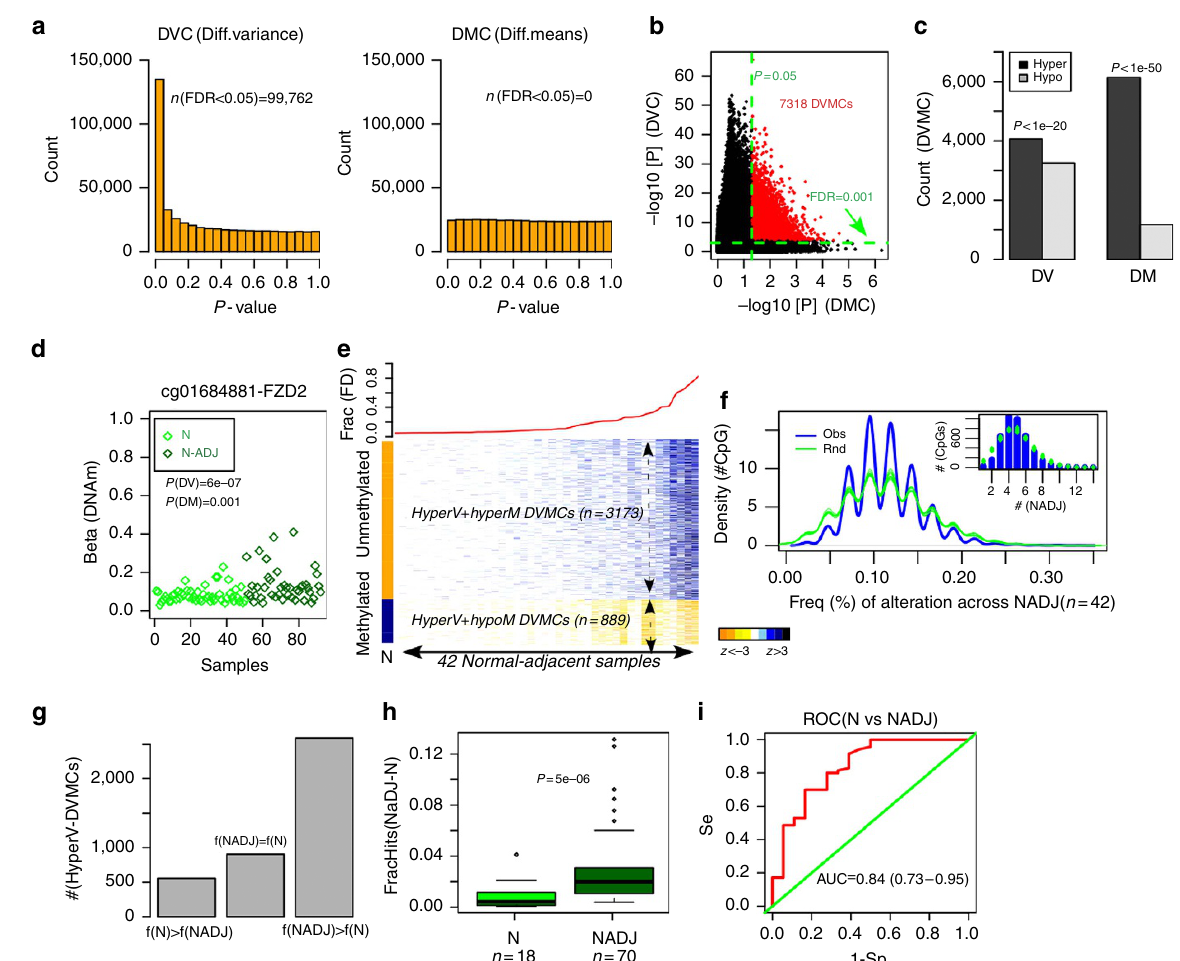
Figure 2 | Identification of stochastic DNA methylation field defects in breast cancer and validation. ( a ) Histograms of P -values from Bartlett’s test (DVC-differentially variable CpGs) and t -tests (DMC-differentially methylated CpGs) comparing 50 normal breast tissue samples from healthy women to 42 normal-adjacent samples from breast cancer patients. The number of probes passing an FDR-corrected threshold of 0.05 are shown. ( b ) Definition of the 7,318 differentially variable and differentially methylated CpGs (DVMCs), as those probes passing an FDR threshold for DVof 0.001 and an uncorrected P -value threshold for DM of 0.05. ( c ) Relative numbers of DVMCs that are hyper-or-hypovariable (DV), and hyper-or-hypomethyled (DM). Binomial P -values are given. ( d ) The DNAm profile of a hypervariable þ hypermethylated DVMC. Y axis labels the DNA methylation beta-value, x -axis labels the samples. P -values shown are for a Bartlett’s test, which tests for DV, and for a t -test, which tests for differential average methylation (DM). ( e ) Upper panel: fraction of hypervariable DVMCs significantly altered in each normal-adjacent sample, with samples ordered in increasing order. Left colour bar depicts the average DNAm beta-value of the hypervariable DVMCs across the 50 normal samples from cancer-free women. Orange: beta-value o 0.2, blue: beta- value 4 0.6. Heat map depicts the z -scores of differential DNAm change for each DVMC and normal-adjacent sample relative to the normal state, with samples ordered according to the overall fraction of alteration. ( f ) Density-histogram plot of the number of hypervariable DVMCs exhibiting a given fraction of DNAm alterations across the 42 normal-adjacent samples (blue curve). In green, we show the density obtained from Monte-Carlo randomization. Inlet figure depicts the same data, but using absolute numbers of CpGs ( y axis) and actual numbers of normal-adjacent samples. ( g ) Relative numbers of hypervariable DVMCs shown in heat map of e , which show a lower [f(N) 4 f(NADJ)], equal [f(NADJ) ¼ f(N)] or higher frequency of alteration [f(NADJ) 4 f(N)] in an independent set of normal adjacent (NADJ) samples compared with normals (N). ( h ) Box plot comparing the frequency of alteration of hyper-DVMCs ( y -axis: FracHits) in the independent set of normal-adjacent (NADJ) and normal (N) samples. P -value is from a Wilcoxon rank sum test. ( i ) Receiver operating curve (ROC)-curve and AUC value plus 95% confidence interval corresponding to h